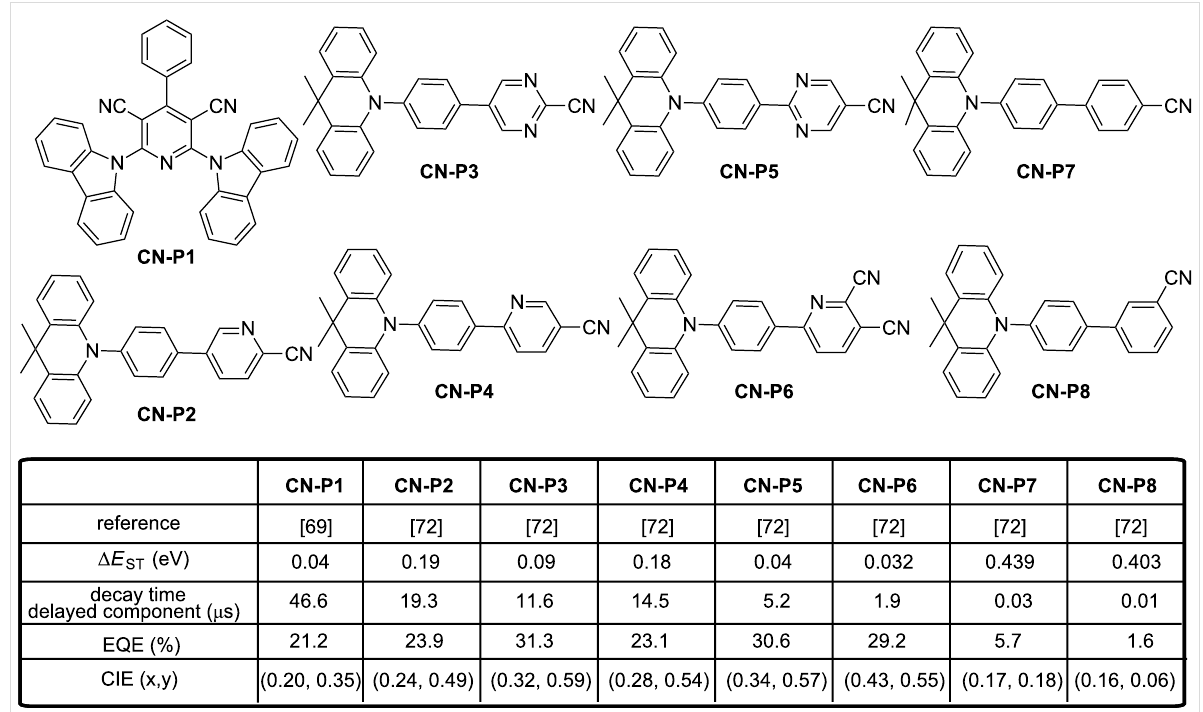
Figure 11: CN-Substituted pyridine and pyrimidine derivatives CN-P1 – CN-P8 .